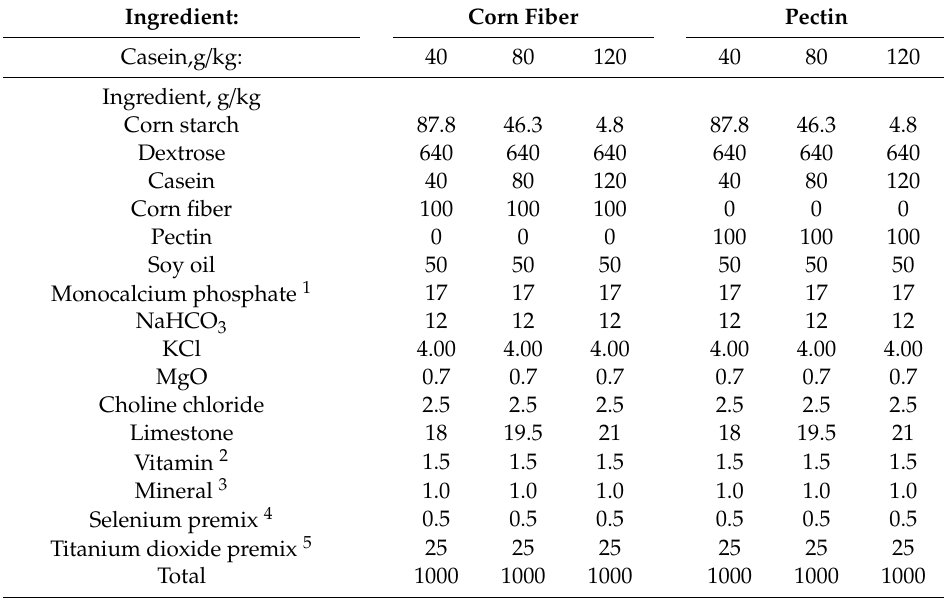
Table 4. Composition of the experimental diets fed to pigs, g / kg (on as-fed basis; Exp.